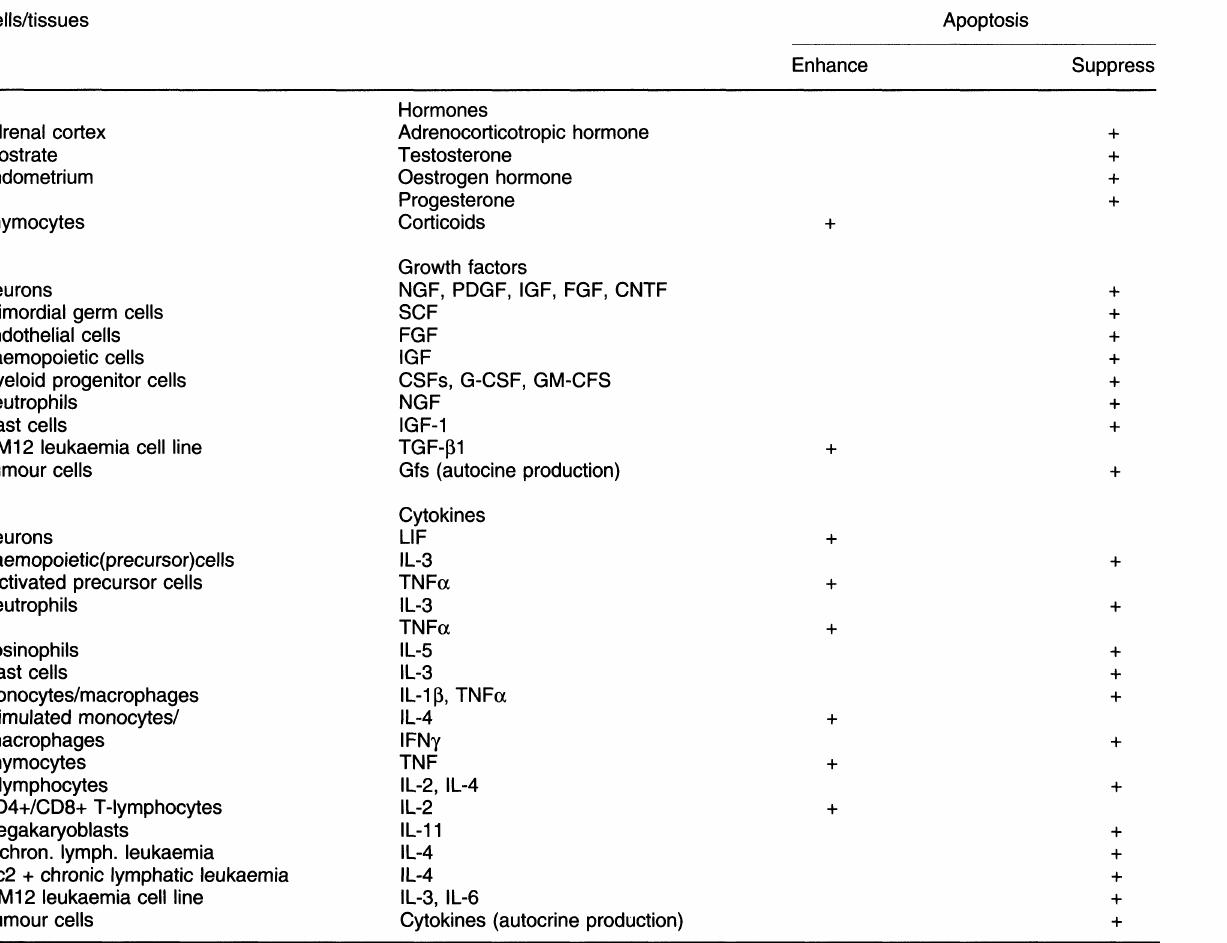
Table 2. Enhancement or suppression of apoptosis by tissue specific hormones, growth factors and cytokines Cells/tissues